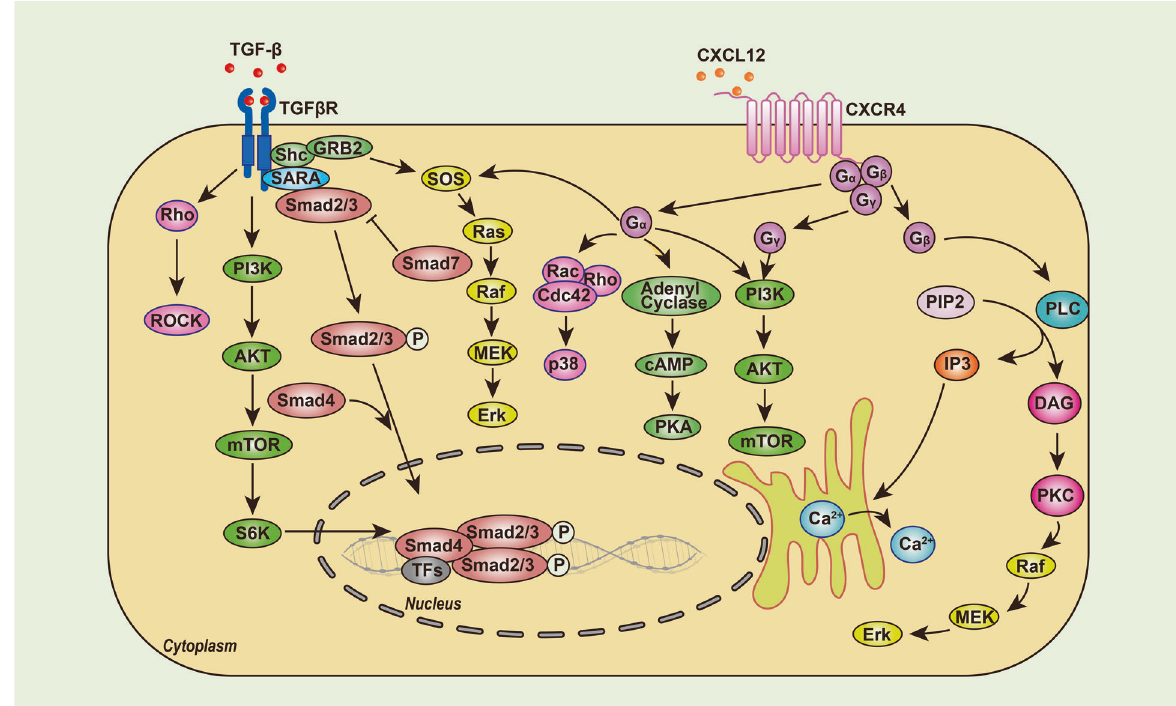
Fig. 3 Intracellular signaling network triggered by TGF- β and CXCL12, two critical factors inducing ECM